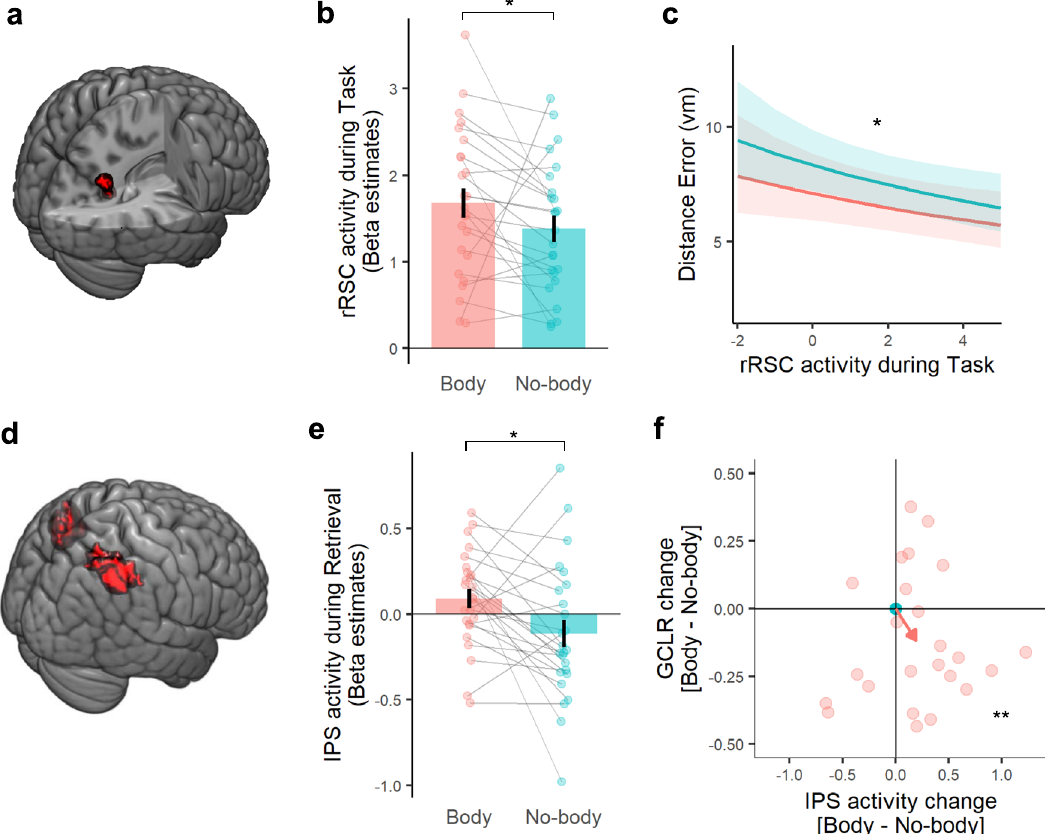
Fig. 4 Retrosplenial cortex (RSC) and intraparietal sulcus (IPS) activity were increased in the Body condition. a Functional localizer revealed that the right RSC was involved in the spatial navigation task. b ROI analysis showed that right RSC was signi fi cantly more activated during the task in the Body condition than in the No-body condition (Bonferroni-corrected for fi ve task-related clusters; n = 25; p = 0.040). c The higher right RSC activity during the task phase before they reach the recalled location (i.e., Cue & Retrieval Phase) could predict better spatial memory precision ( n = 25; p = 0.024). d Anatomical display of the a priori IPS ROI arguably activated during egocentric processing in link with BSC. e IPS activity is signi fi cantly greater during navigation in the Body condition ( n = 25; p = 0.015), where sensorimotor bodily signal integration takes place when participants are manipulating the joystick to navigate. This suggests that the experimental modulation of BSC boosted egocentric processes especially relevant to integrating sensorimotor bodily signals. f Participant-wise IPS activity changes and GCLR changes in the Body condition with respect to the No-body condition. The plot demonstrates that performing the task with a self-identi fi ed avatar reduced GCLR while strengthening the IPS activity (multinomial test: p = 5.4e-03, post hoc binomial test: p = 3.1e-03, n = 24). The red arrow indicates mean changes across participants. * 0.01 < p < 0.05, ** p < 0.01. Each error bar indicates a standard